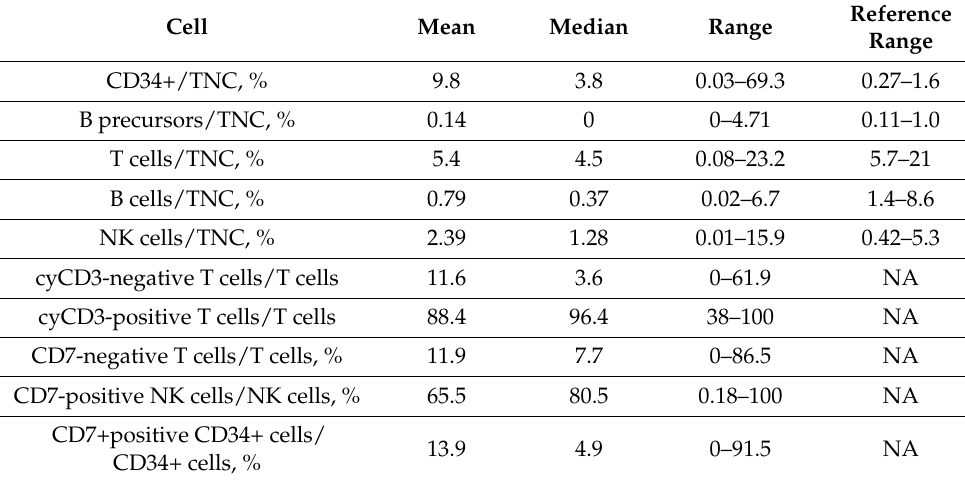
Table 2. Distribution of bone-marrow cells.